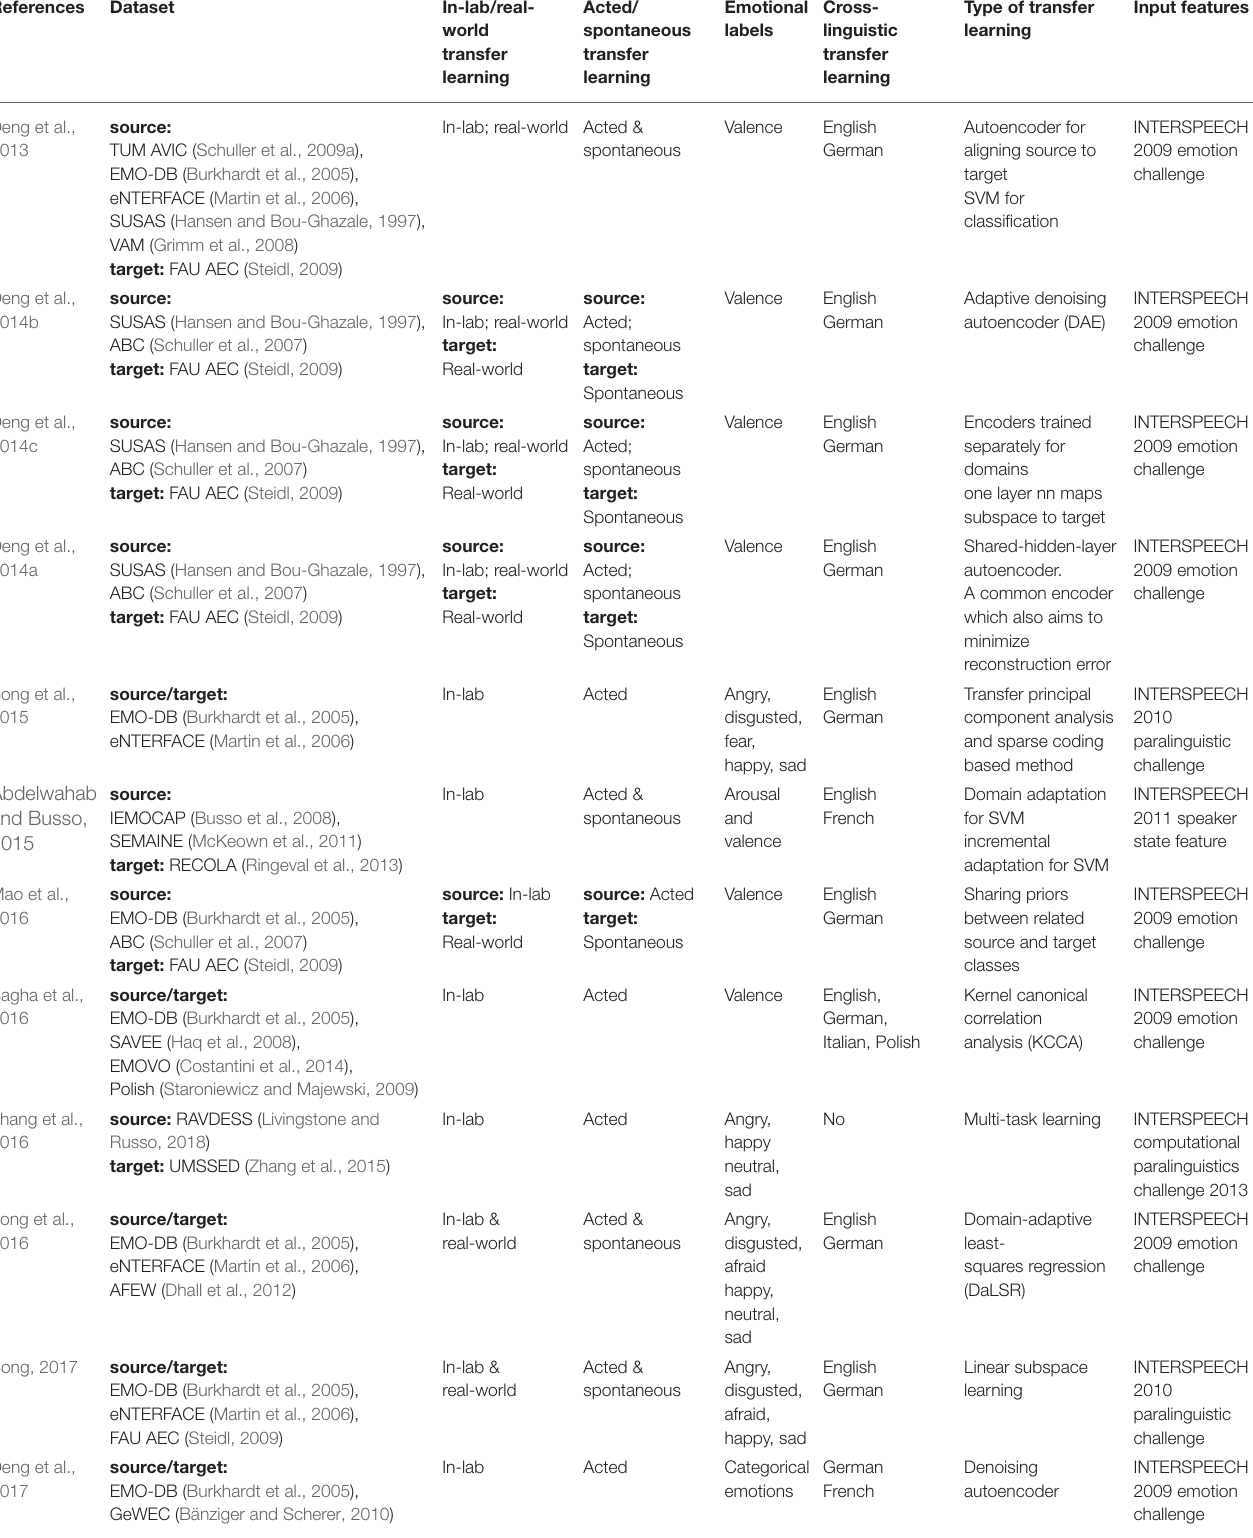
TABLE 1 | Overview of previously proposed transfer learning methods for speech-based emotion